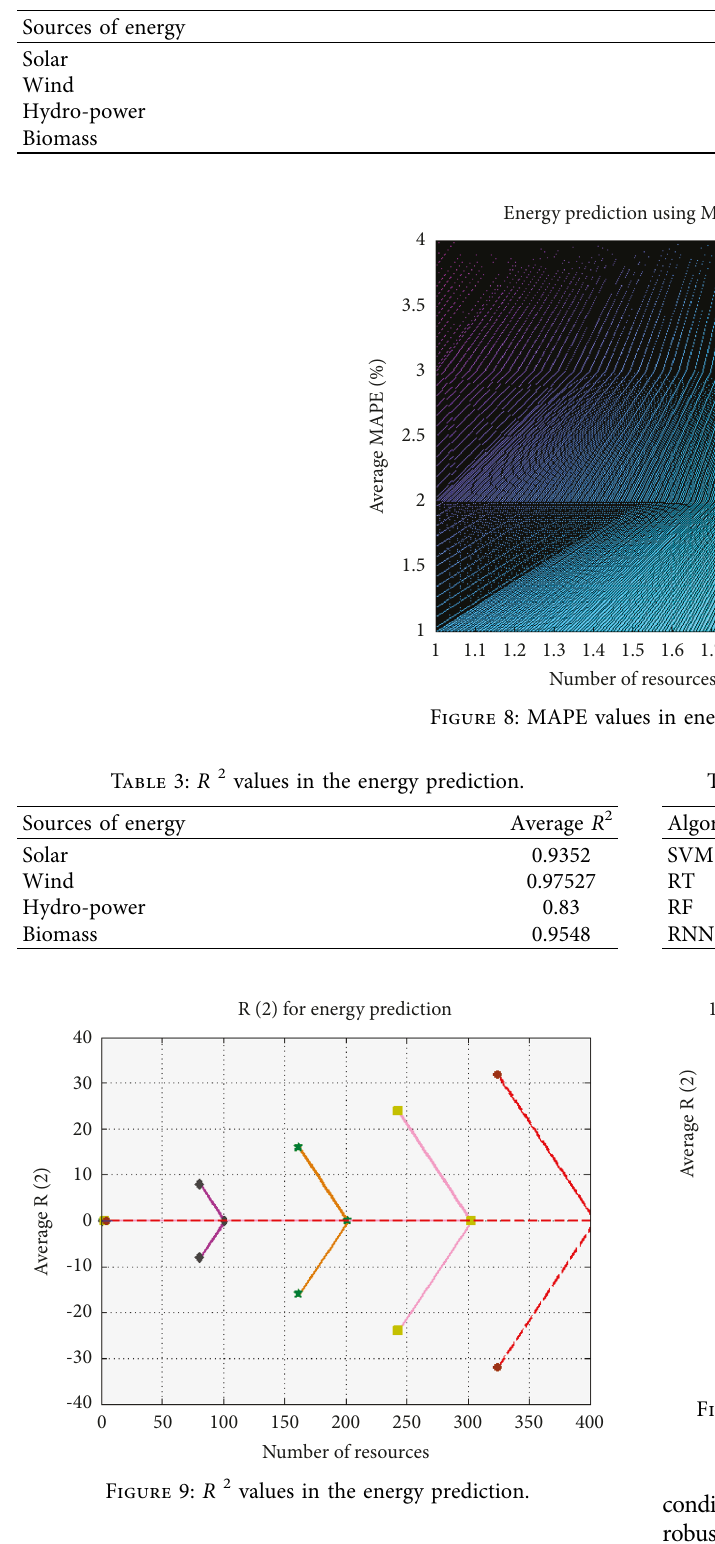
Table 2: MAPE values in energy